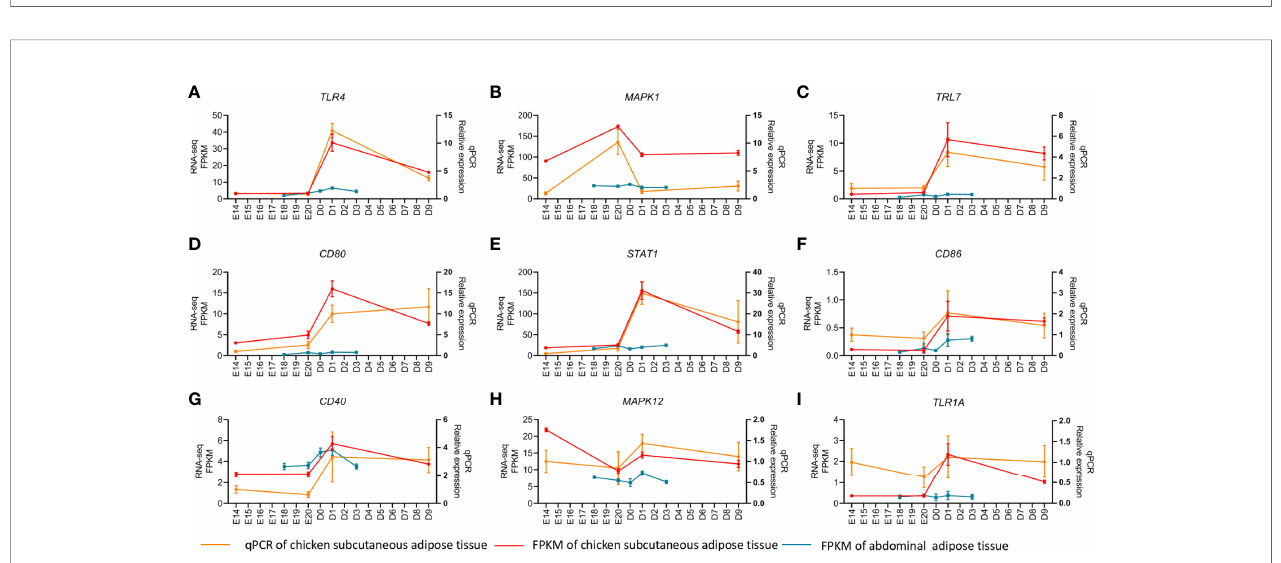
FIGURE 7 | KEGG enrichment of different modules of chick subcutaneous and abdominal adipose tissues from embryonic to post-hatch development by WGCNA. (A) KEGG enrichment of different modules of chick subcutaneous adipose tissue in four development stages by WGCNA; (B) KEGG enrichment of different modules of chick abdominal adipose tissue in fi ve development stages by WGCNA; (C) hub genes identi fi cation of turquoise module in chick subcutaneous adipose tissue in four development stages.